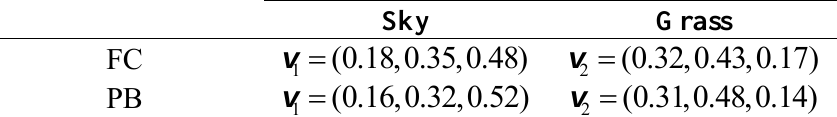
Table 2. Cluster centres for the sky and grass textures.